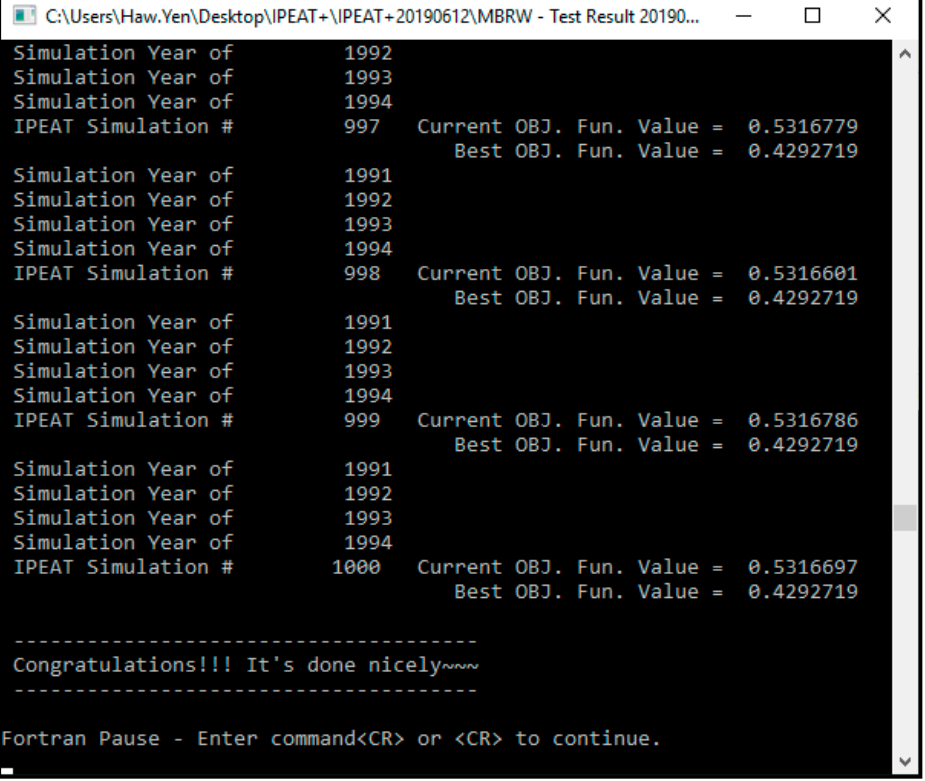
Figure 9. MS-DOS Command window of IPEAT+ execution with the latest updates on current and the best objective function